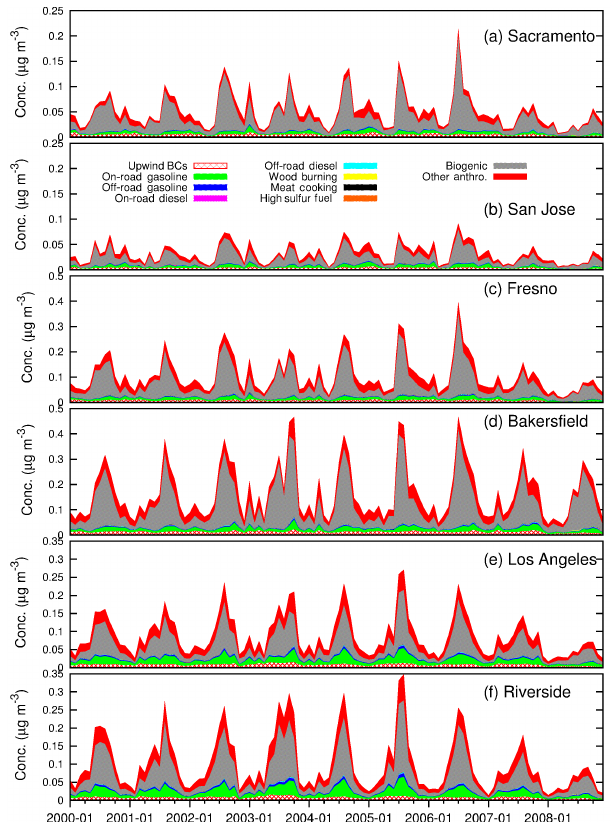
Figure 6. Monthly source contributions to PM 0 . 1 SOA at six urban sites. Predicted PM 0 . 1 SOA concentrations from different sources are indicated by the colored